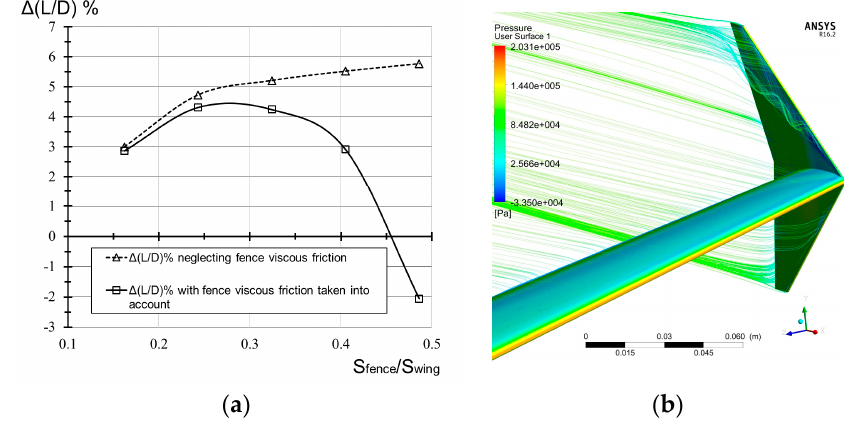
Figure 8. ( a ) Influence of oval planform end plates relative area on L/D ratio growth (%) of DLR-F4 model at M = 0.75 and α = 3°. Solid line graph reveals the negative effect of viscous friction for fences of large areas; ( b ) Surface pressure field and streamlines over a delta planform wingtip fence at M = 0.8 and α = 1°.